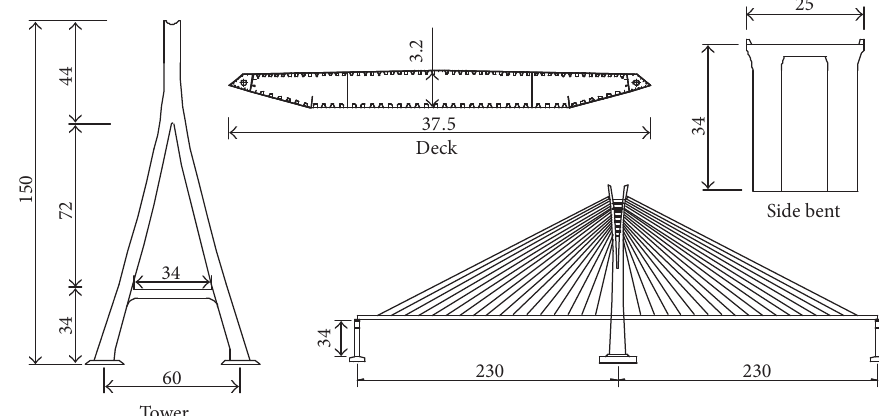
Figure 1: Schematic of the Puqian cable-stayed Bridge